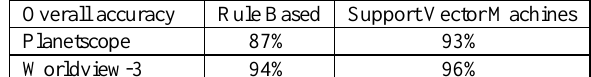
Table 1. Overall accuracies of produced